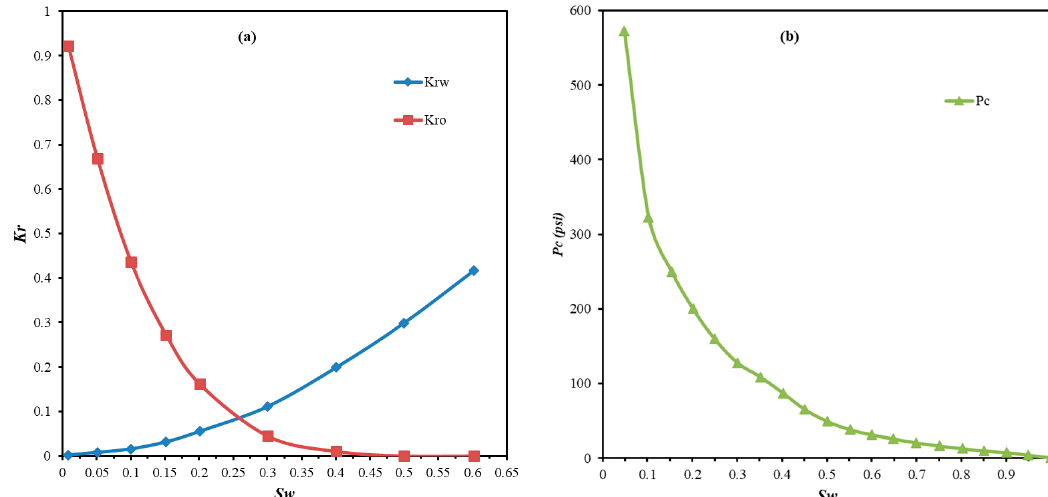
Figure 6. The relative permeability ( K r ) curves ( a ) for water and oil phases based on drilling core tests [23] and capillary pressure ( P c ) curve ( b ) referencing a common carbonate rock data [29,30]. K rw is the relative permeability of water, K ro is the oil permeability relative to water, P c is the mercury-air capillary pressure.